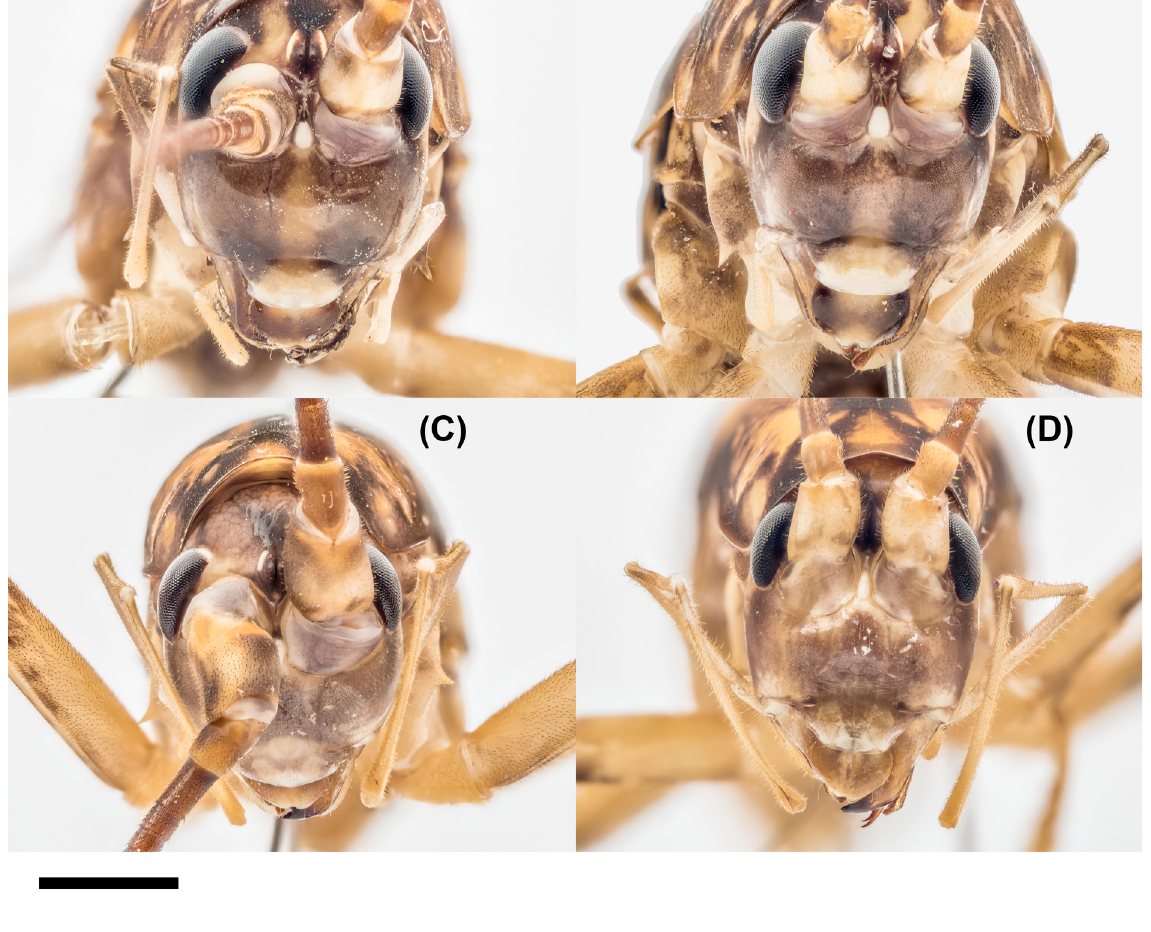
Fig. 5. Head of cave wētā in the genus Miotopus hutton, 1898 showing sexual dimophism. A–B . Miotopus diversus (hutton, 1896). A . Adult ♂, Resolution Bay, Queen Charlotte Sound (MPN CW3459). B . Adult ♀, Camp Bay, Queen Charlotte Sound (MPN CW3596). C–D . Miotopus richardsi sp. nov. Borland road, Southland. C . Adult ♂ (MPN CW3542). D . Adult ♀ (MPN CW3811). Scale bar = 2